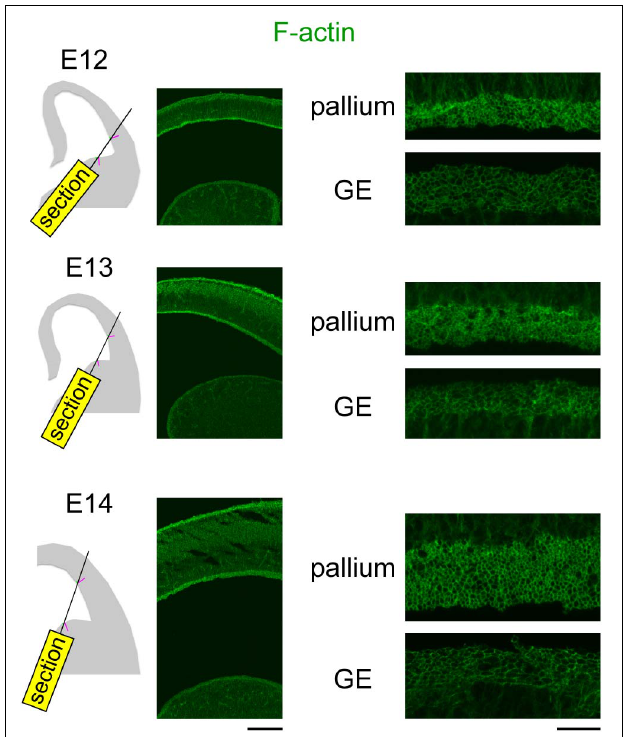
FIGURE 6 | Photomicrographs showing confocal images of F-actin (green) obtained in the pallium and the GE at E12–E14. Plane of sectioning is schematically shown in the left panels: magenta line is perpendicular to the apical surface, while green lines represent F-actin + apical surfaces simultaneously captured in the pallium and GE. Scale bar, 0.2 mm (left) and 20 µ m (right).